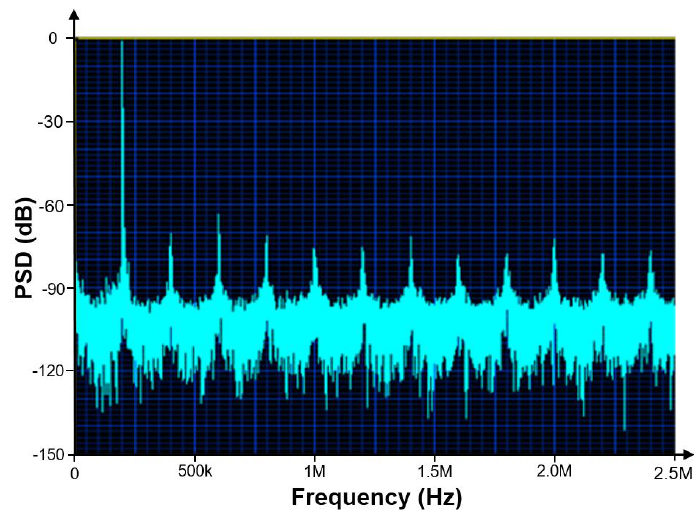
Figure 25. Measured 32,768-point PSD of the proposed PLL-SAR ADC at input frequency of 200 kHz.